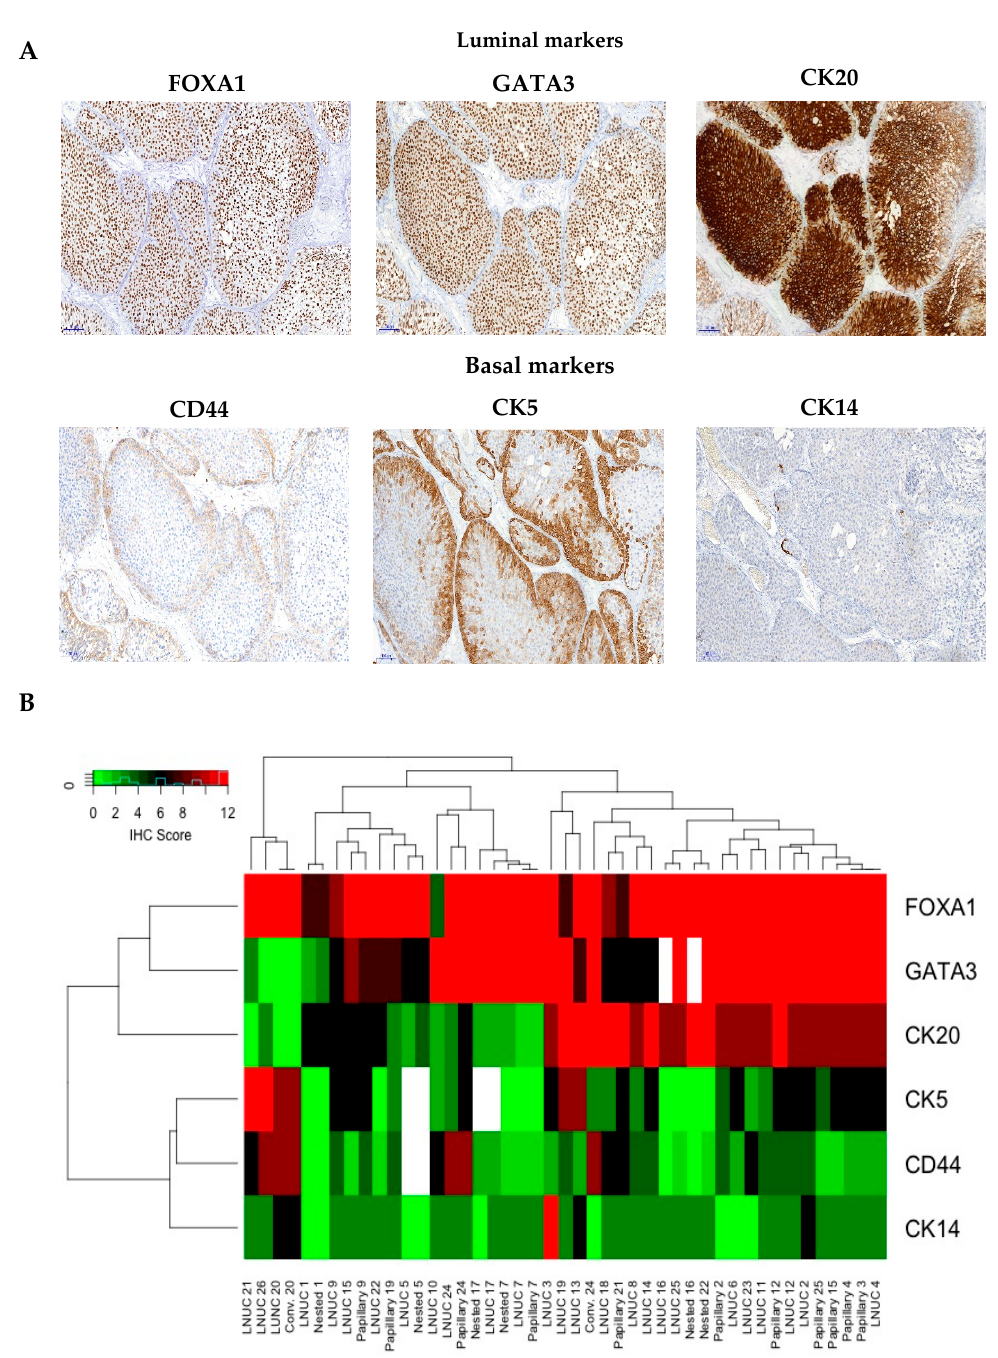
Figure 3. ( A ) Immunohistochemistry with luminal and basal markers, representative images (all 100 fold orginial magnification); ( B ) Heatmap presenting results of di ff erential immunohistochemistry with luminal and basal markers; each column represents one tumor component of each patient; white fields: not available; red fields: high IRS scores; green fields: low IRS